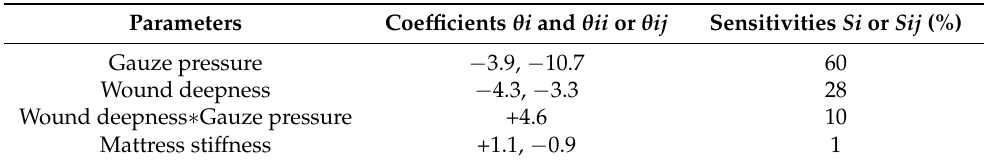
Table 3. Parameter coefficients and polynomial model sensitivities (>1%) in decreasing order of magnitude. Parameters Coefficients θ i and θ ii or θ